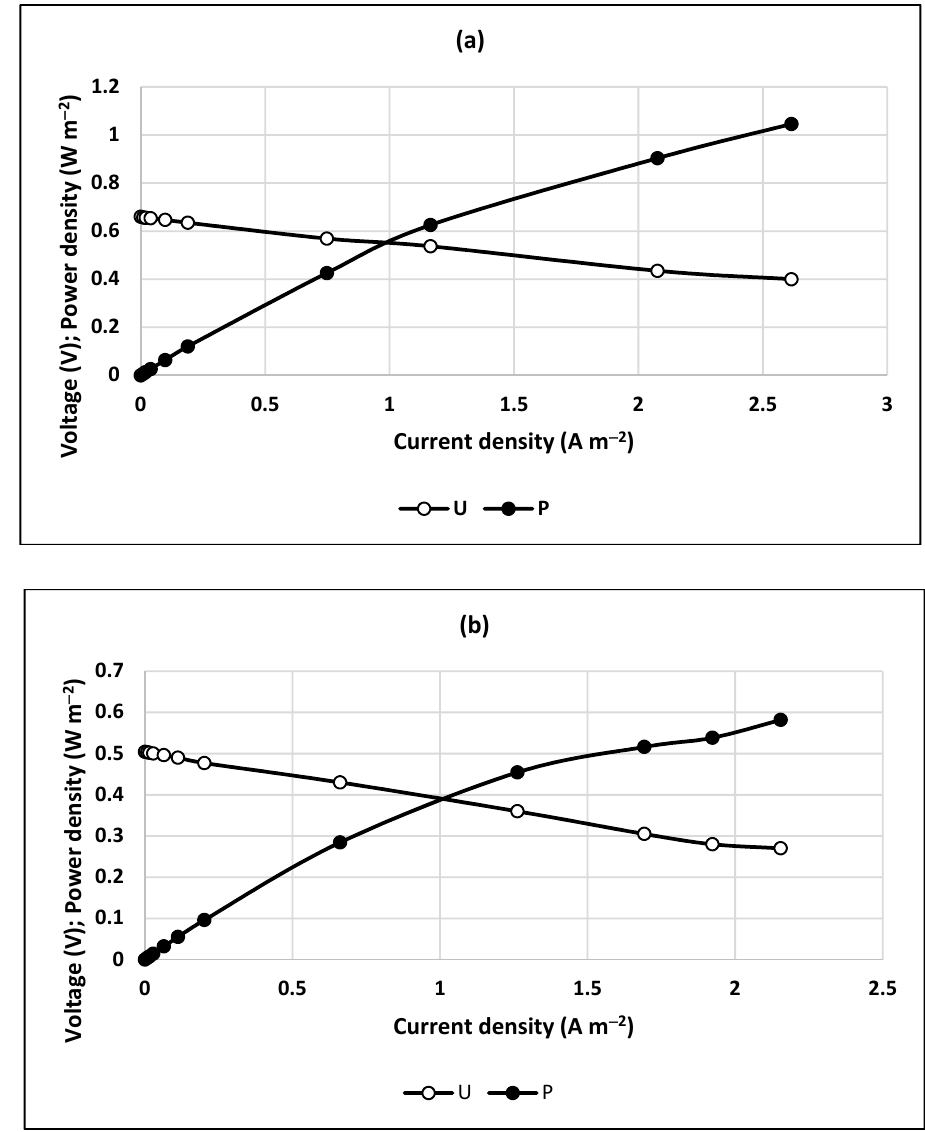
Figure 5. Polarization curve and power density dependence for a single fuel cell with preliminary aeration in Venturi-tube ejector, feeding flow rate 1 dm 3 /h. ( a ) Continuous feed, sulfide concentration 190 mg dm − 3 ; feeding flow rate 0.4 dm 3 /h. ( b ) Batch process, 260 mg dm − 3 .